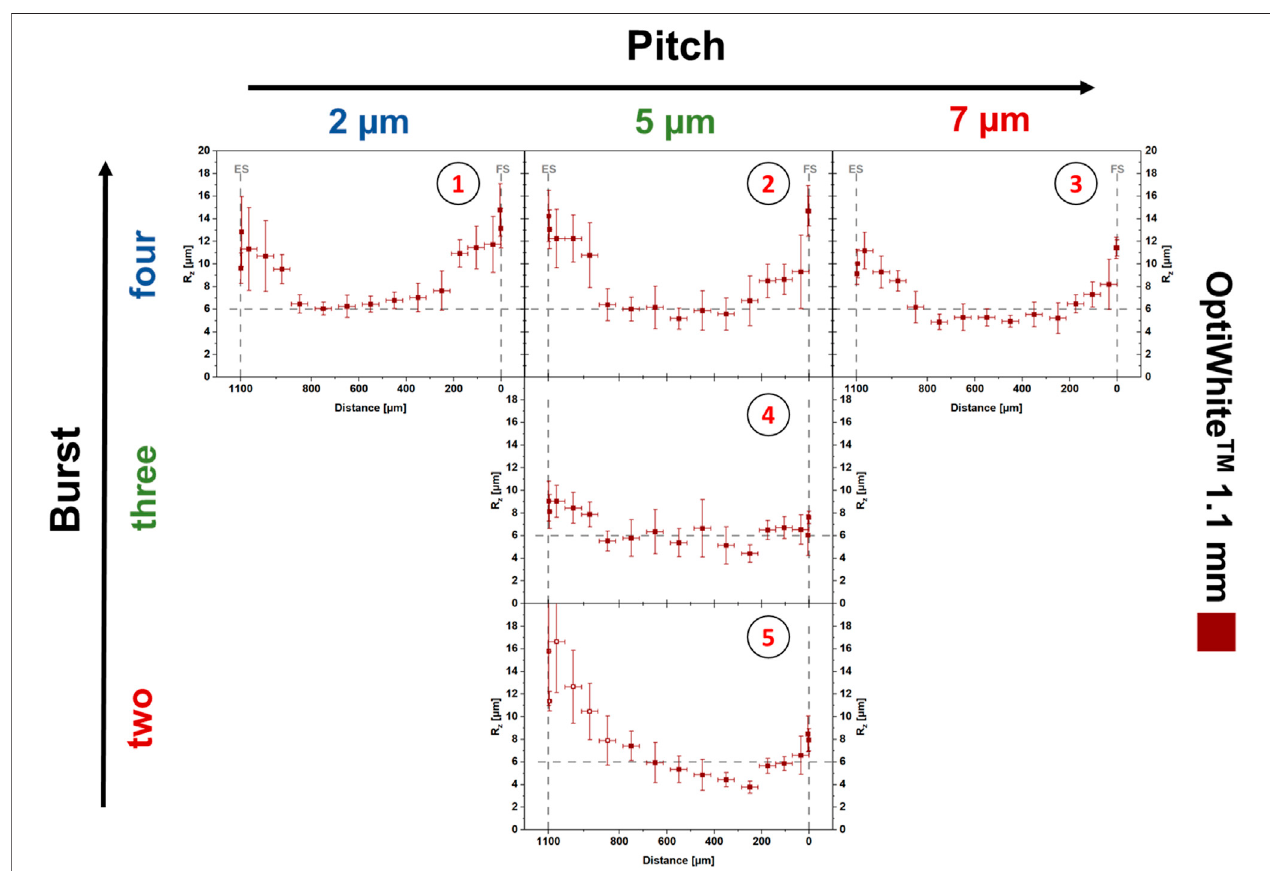
FIGURE 7 | Maximum roughness R z pro fi les along the cross section for the OptiWhite ™ 1.1 mm series. Gray dashed lines are guide to the eye, i.e., horizontal line fi xed at 6 µm and mark Entry- and Focus-Side (vertical). Increased roughness at the Entry- and Focus Side can be seen, while the middle area remains at lower values. Hollow symbols in graph 5 indicate ineffective fi lamentation with a characteristic glassy fracture pattern, which is responsible for the elevated values.